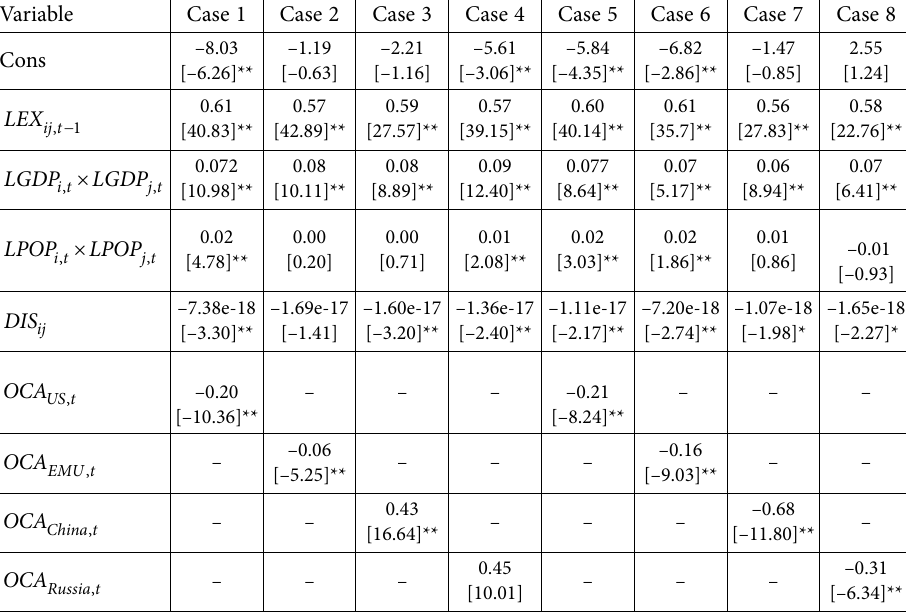
Table 4. Estimated results for Iran and its major trade partners’ bilateral trade (2000–2018) (source: own research)